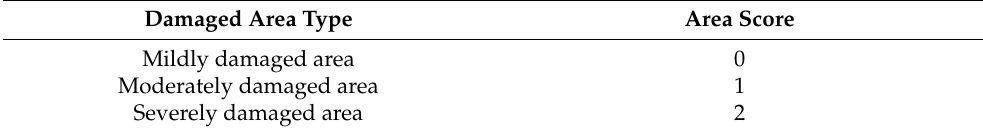
Table 6. Score of the damaged area type.